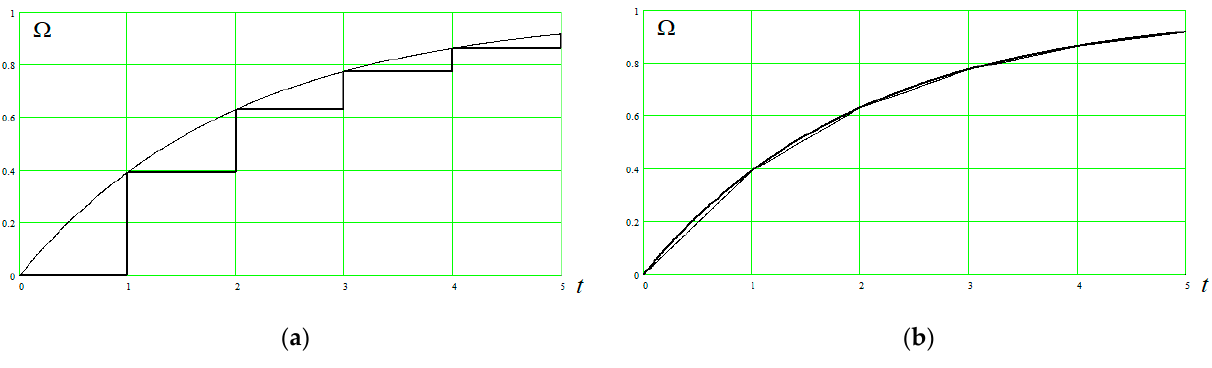
x is shown, evaluated by 1 x  (bold line) obtained 1 3 1 10 − Δ = ⋅ [7].